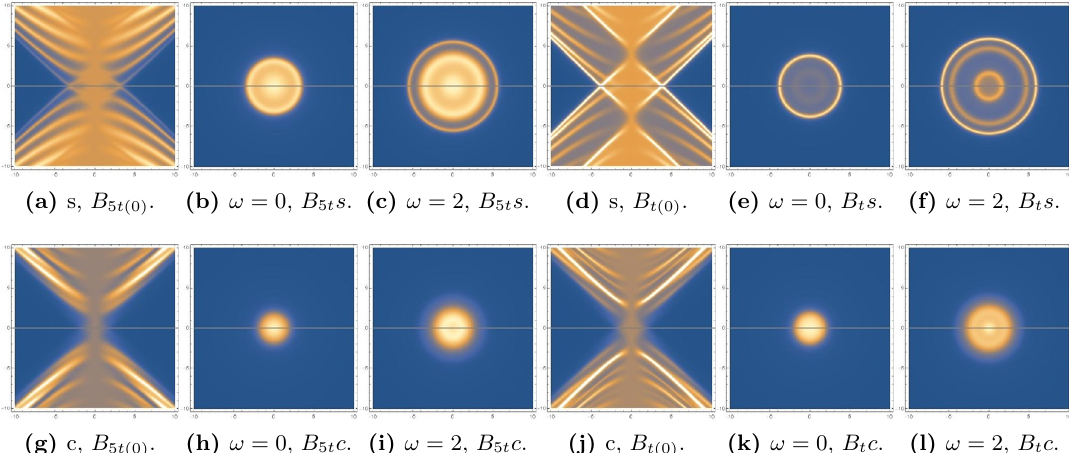
Figure 10. Spectral function with (pseudo) vector source interactions (a-f), and SF with (pseudo)- vector condensation (g-l). s means source and c means